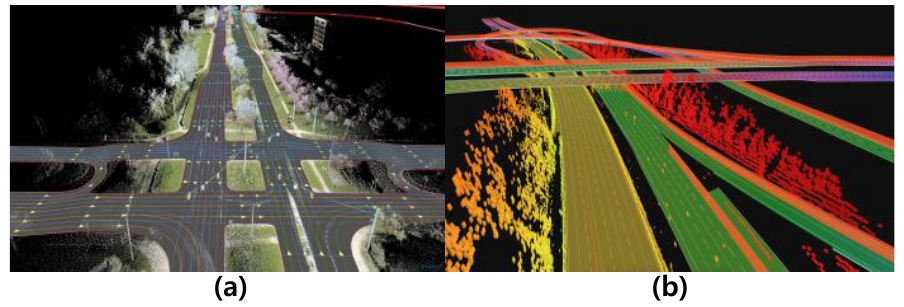
Figure 1. Examples of the HD map. ( a ) HERE ( b )